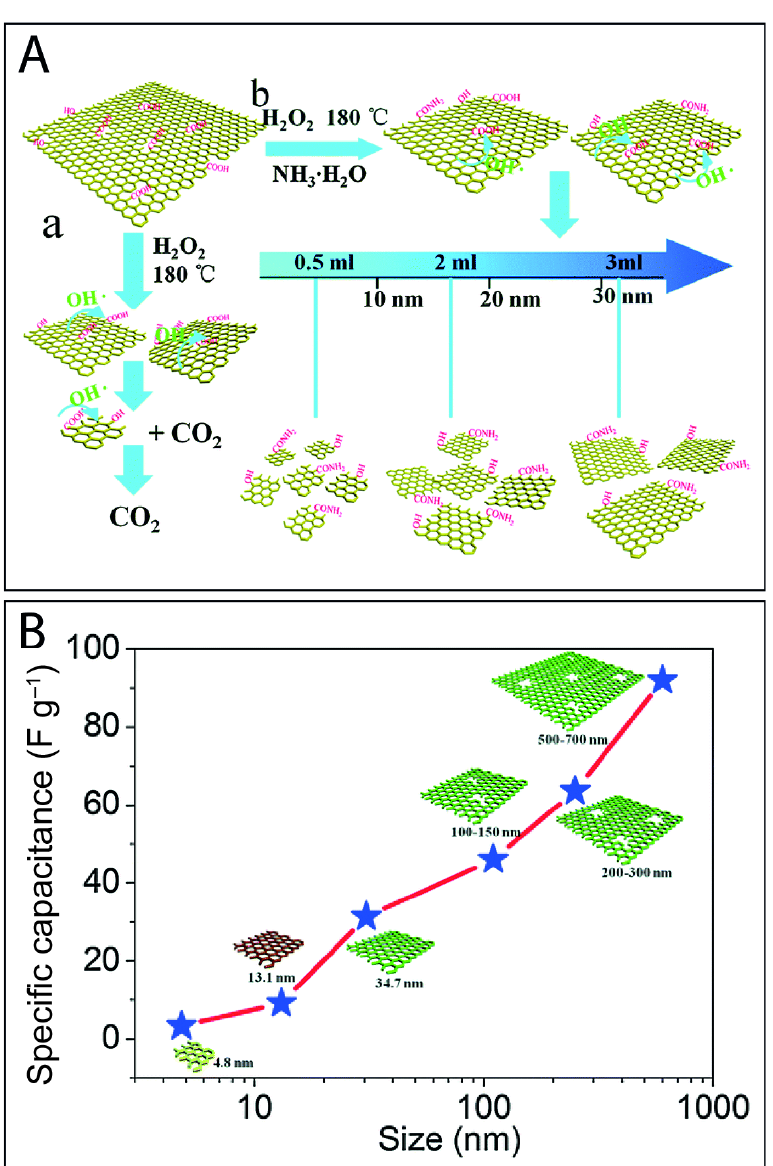
Figure 4. ( A ) Schematic representation of the process to produce GQDs with different sizes and ( B ) specific capacitance as a function of GQDs size. Reproduced with permission from reference [143]. Copyright 2015 The Royal Society of Chemis- try.